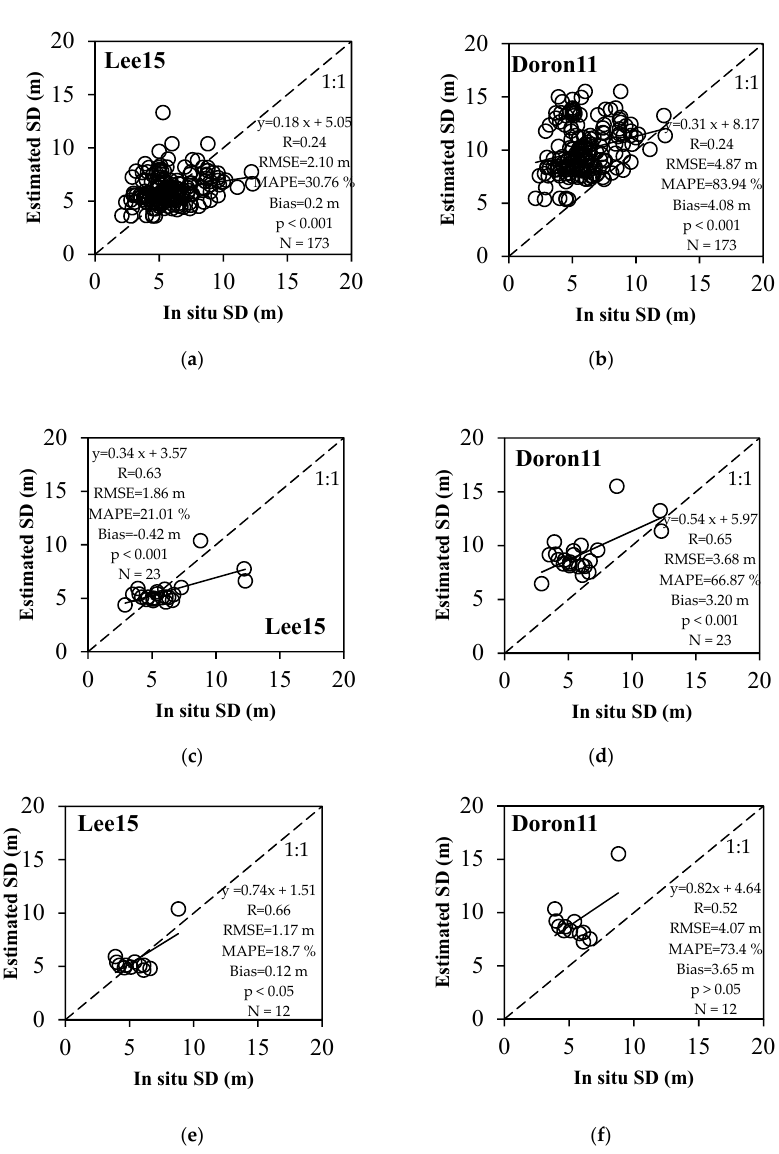
Figure 4. Comparison of in situ measured SD values and MERIS-derived SD values: ( a ) using the Lee15 algorithm for all available in situ SD measurements; ( b ) using the Doron11 for all available in situ SD measurements; ( c ) using the Lee15 for matchups on the same day; ( d ) using the Doron11 for matchups on the same day; ( e ) using the Lee15 for matchups within 3 h; ( f ) using the Doron11 for matchups within 3 h.